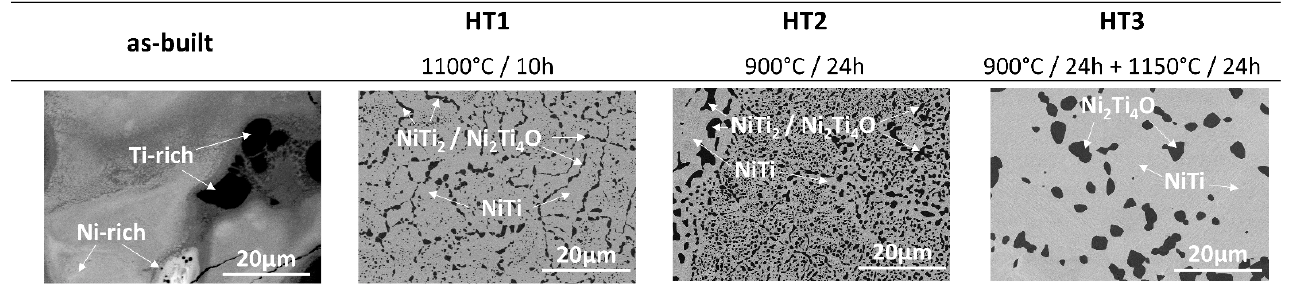
Figure 4. BSE SEM observation of the as-built sample; HT1 (1000 °C/10 h), HT2 (900 °C/24 h), and